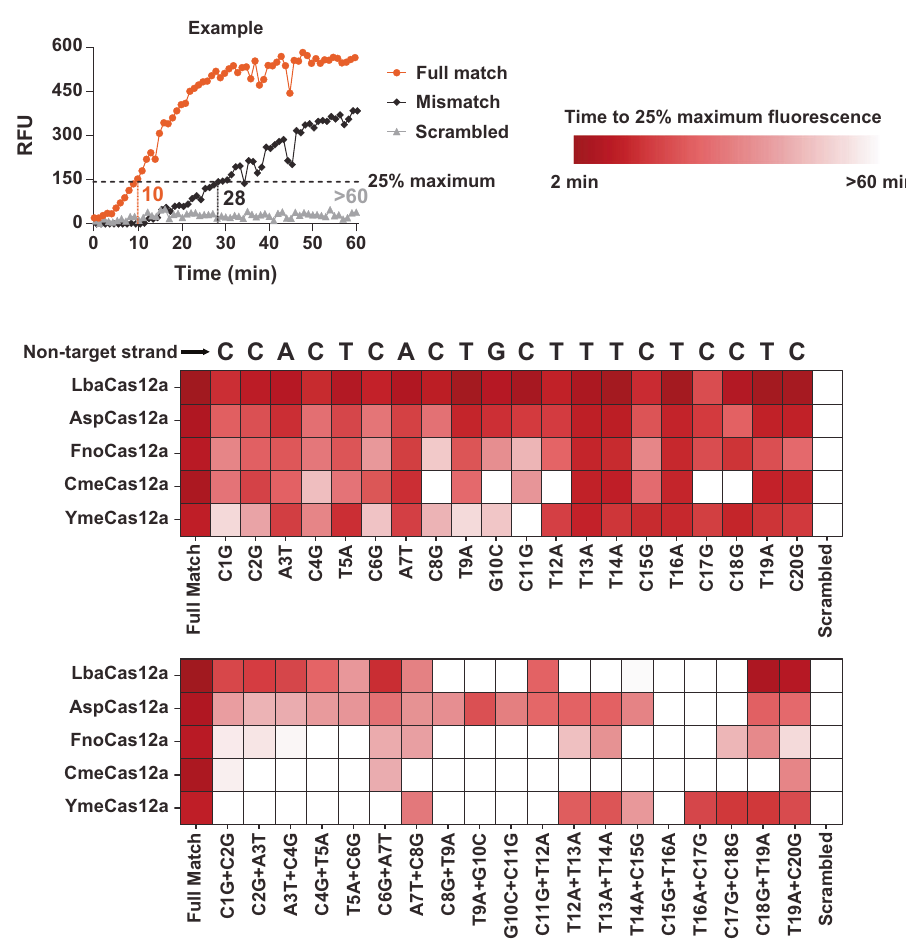
Fig. 9 Cas12a orthologs tolerate mismatches between crRNA and target DNA for activation of trans nuclease activity. Trans nuclease activity generated by Cas12 RNPs was measured using in vitro assays containing target DNA and a 25 nt single-stranded DNA reporter oligonucleotide with 5 ′ fl uorophore (FAM) and 3 ′ quencher (Q) modi fi cations. Target DNAs were identical in sequence except for nucleotide identity at the indicated positions relative to the fi rst nucleotide of the non-target strand sequence. Compensatory substitutions were present in the target strand of the DNA to maintain the potential for proper base pairing between the two strands of target DNA. Fluorescence was monitored over time and recorded in 1 min increments for 60 min. The time it took for each reaction to reach 25% of the maximum relative fl uorescent units (RFU) attained by the fully matched target DNA reaction was determined (see Example graph) and a heatmap was generated where the intensity of the red color corresponds to the time. Reactions were performed at 37 °C for Lba, Asp, and Fno while Cme and Yme reactions were performed at 55 °C. The source data used to make the graph can be found in Supplementary Data